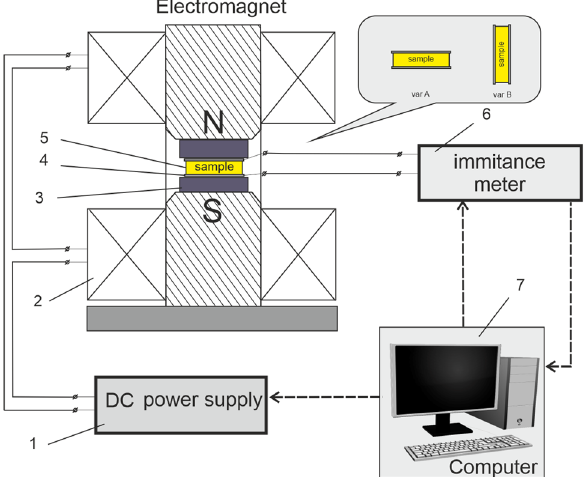
Fig. 5 Schematic of the experimental setup used for measuring the magnetoresistive and magnetodielectric properties of MAE: 1—power supply unit, 2—electromagnet, 3—dielectric spacer, 4— copper plates being the electric contacts, 5—MAE sample, 6—LCR meter, 7—PC supplied with an ADC and